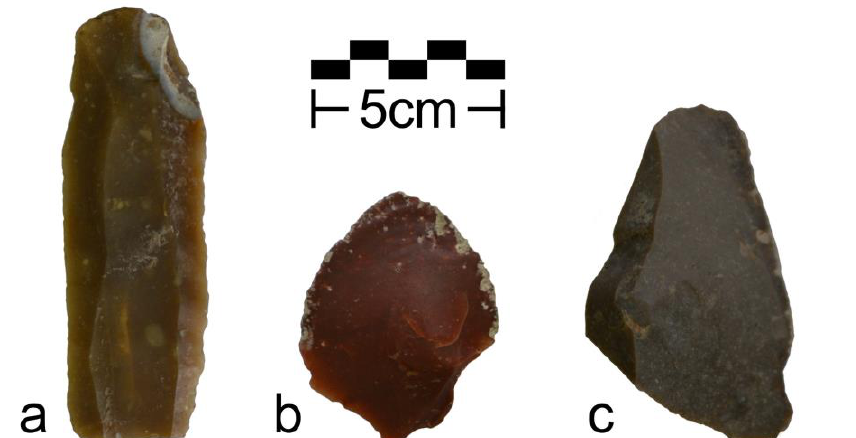
Figure 13. Examples of blades from Măgura